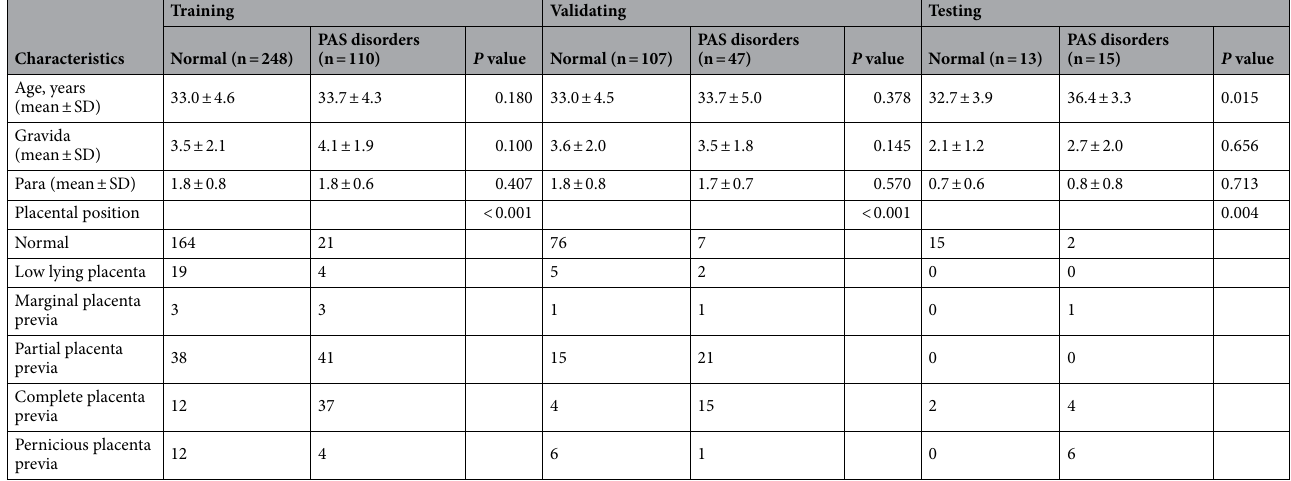
Table 2. Summaries of clinical characteristics in the training, testing and external testing cohort. P value of all characteristics are calculated by one of independent-samples t-test, Mann–Whitney U-test or chi-squared test based on their distribution.